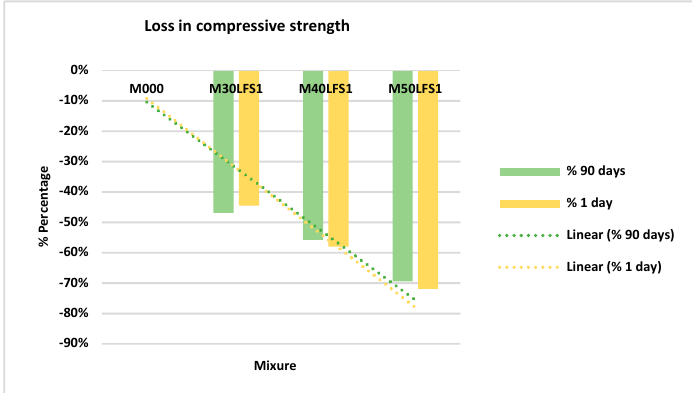
Figure 6. Percentage of loss in compressive strength LFS1.